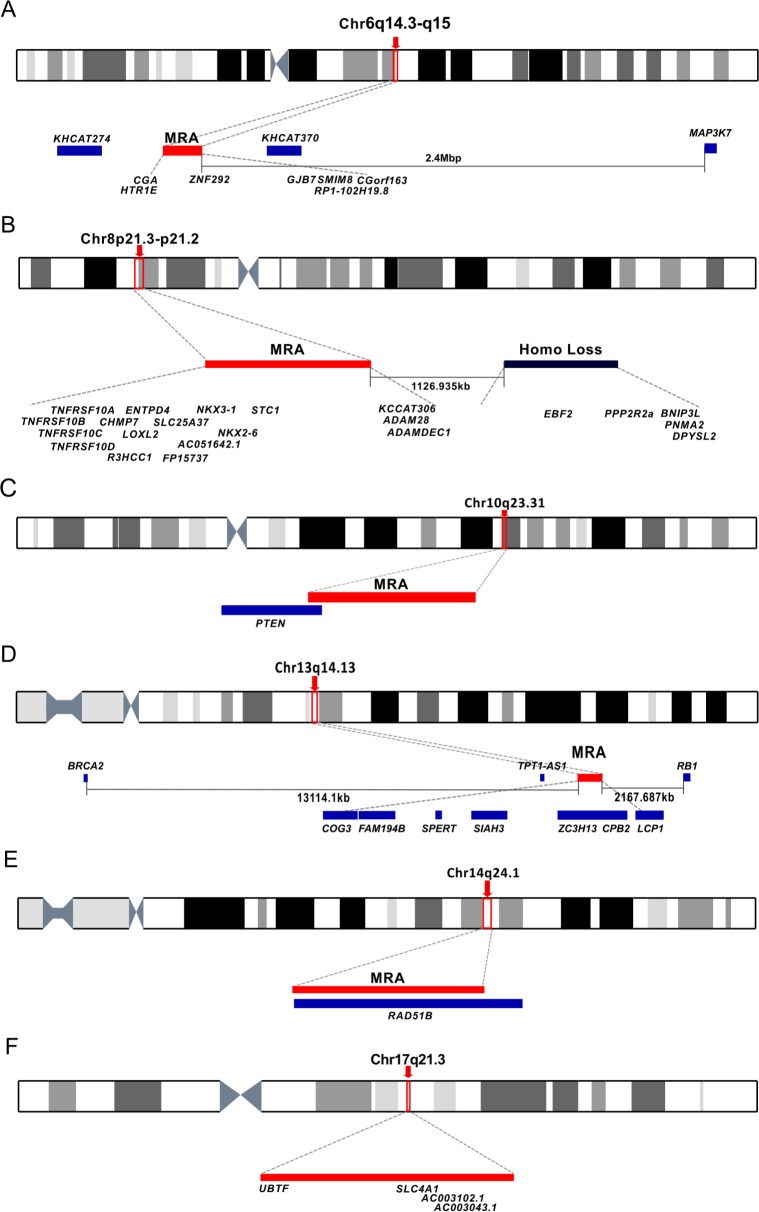
Examples of minimal recurrent deletions.Deletions at (A) 6q14.3-q15, (B) 8p21.3-p21.2, (C) 10q23.31, (D) 13q14.13, (E) 14q24.1 and (F) 17q21.31. The genomic location of the MRA and linked genes are displayed. For the loss at 8p a recurrent region of homozygous loss (8:25417422–26386565) close to the MRA is indicated.